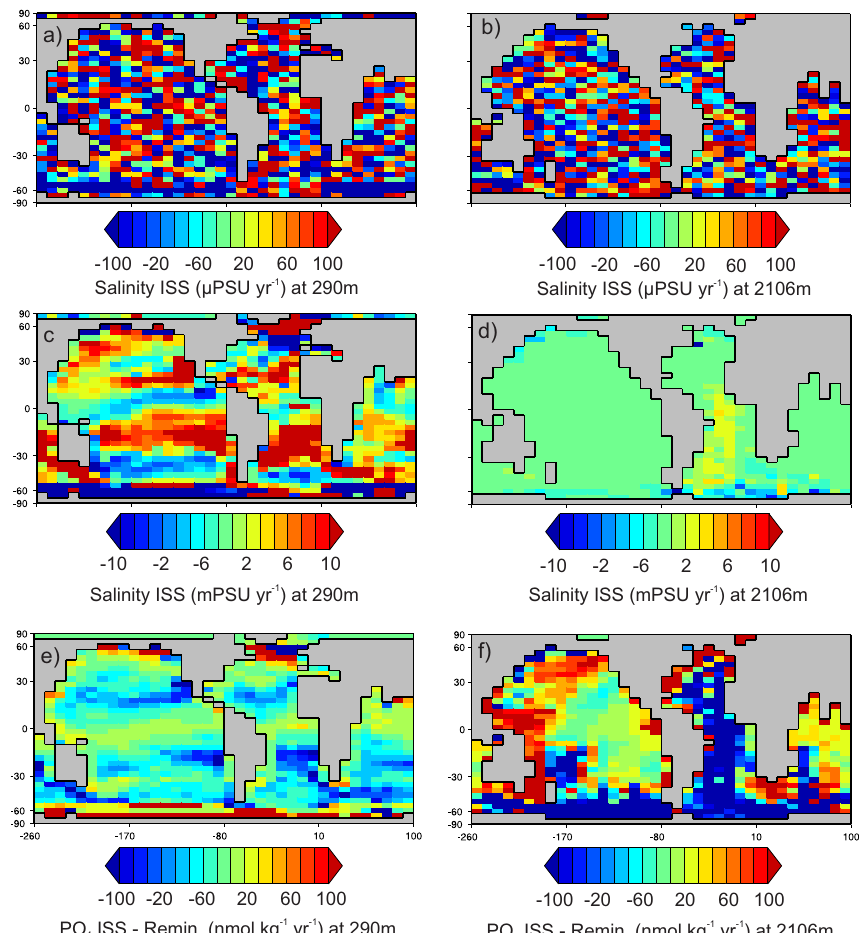
Figure 9. Inversion of salinity as a possible constraint on the uncertainty from using a modelled circulation. (a) Inversion of the salinity field from the synthetic data set using the corresponding transport matrix at 290m (PSU yr − 1 ) and at (b) 2106m. (c) Inversion of the salinity field using a alternative transport matrix from the perturbed-physics ensemble (PSU yr − 1 ) at 290 and (d) 2106m. (e) The error of the synthetic PO 4 ISS (µmolkg − 1 yr − 1 ) (ISS – synthetic) using the same transport matrix in panels (c, d) at 290 and (f)